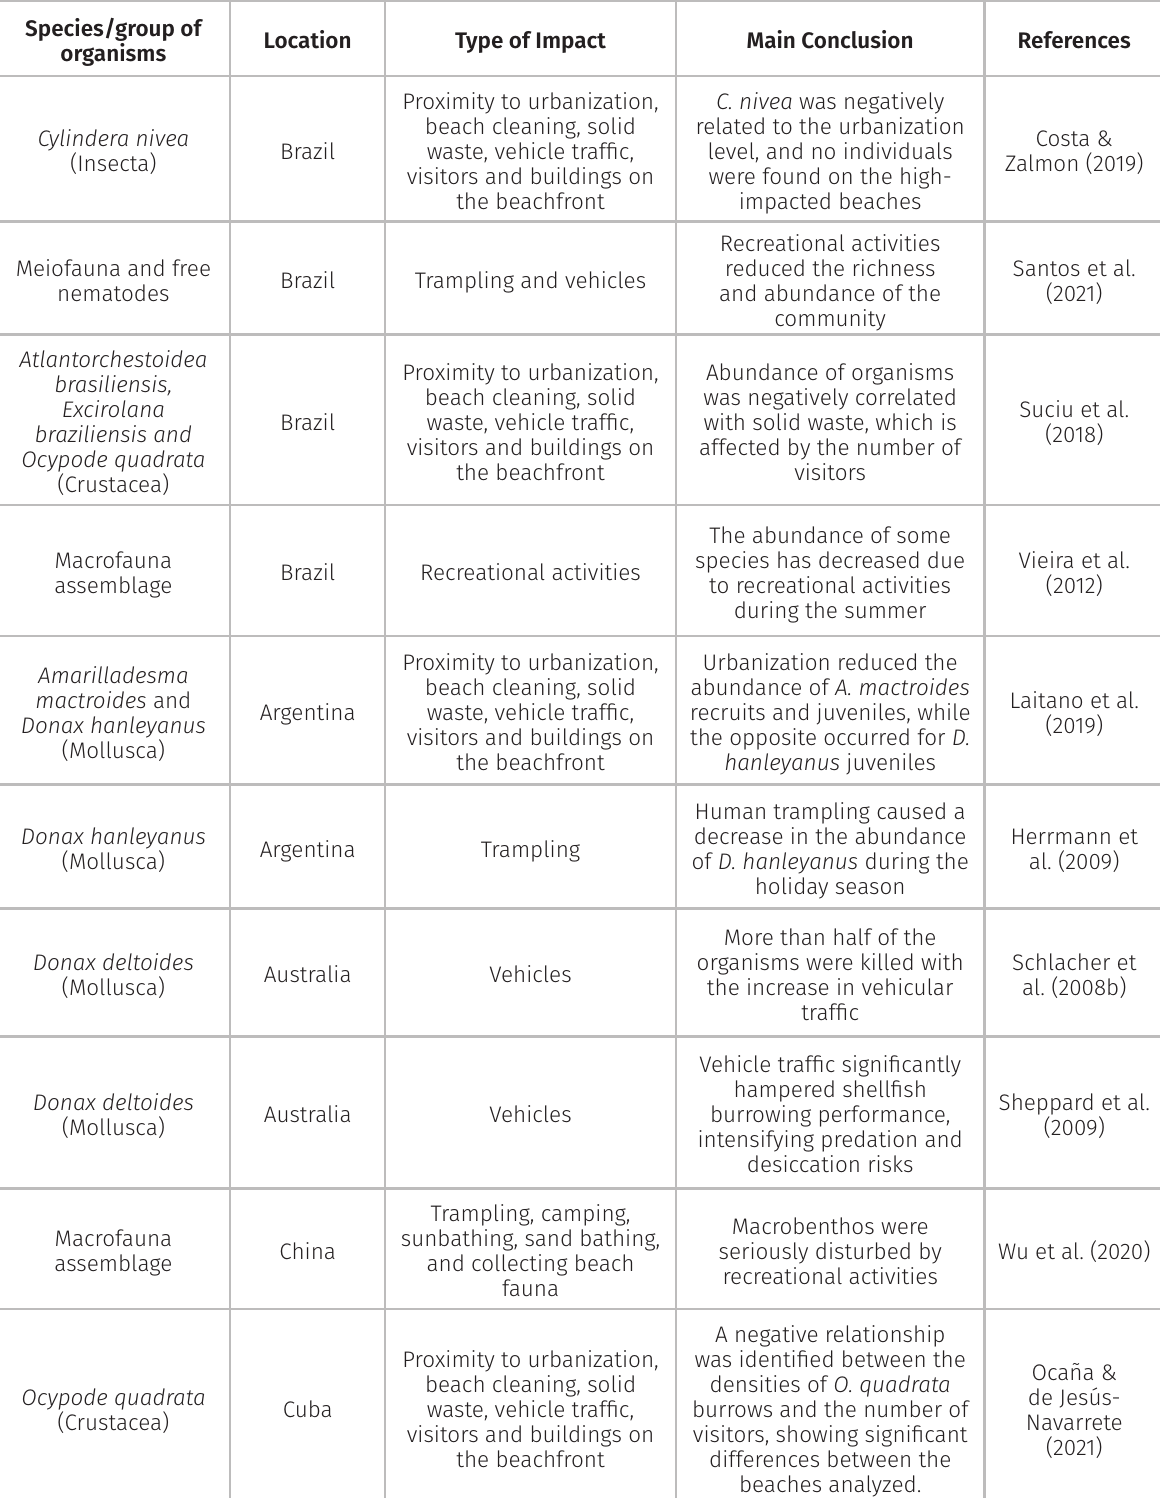
Table II. Summary of studies that verified recreational impacts on the benthic fauna of sandy